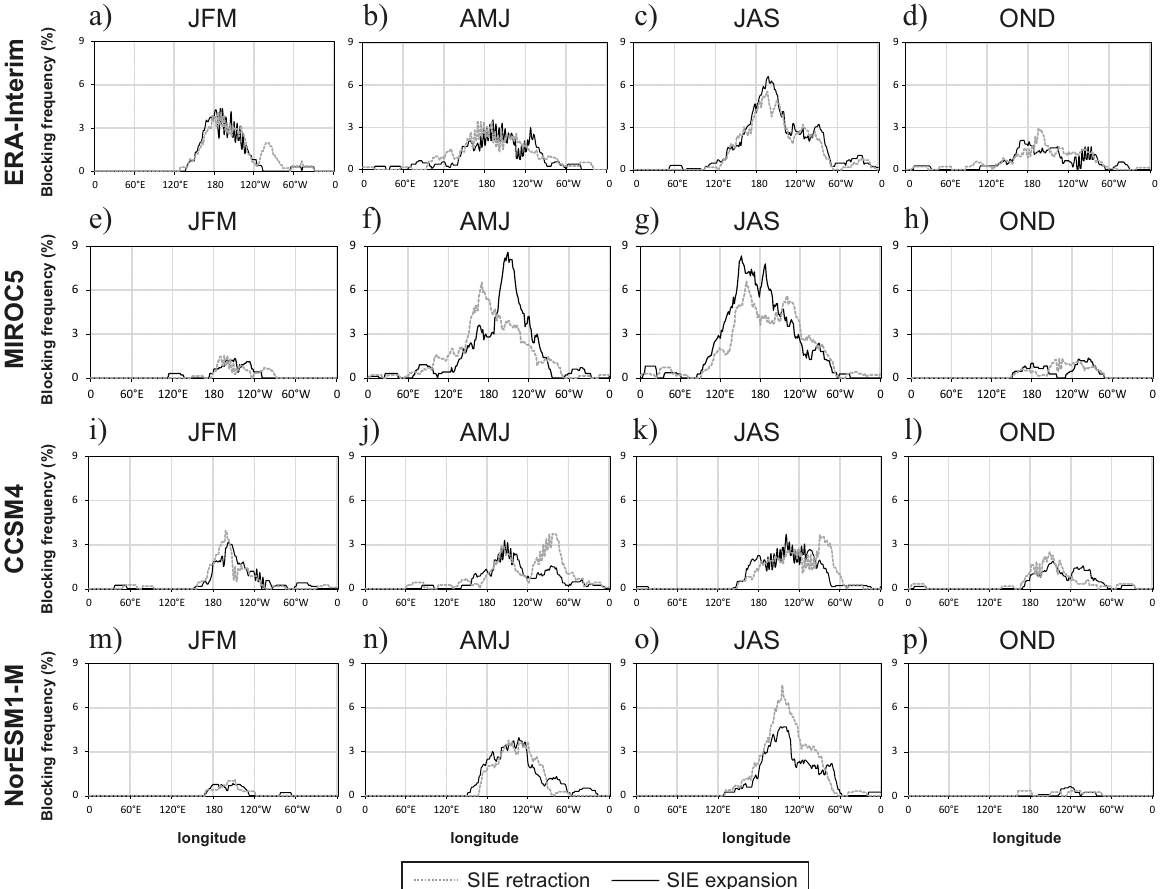
Figure 8. Seasonal frequency of blocking events, in the 48°S latitude band, in years of SIE Antarctic retraction (gray line) and expansion (black line) for (a, b, c, d) observed data (satellite and reanalyses), (e, f, g, h) MIROC5, (i, j, k, l) CCSM4 and (m, n, o, p) NorESM1-M during summer (JFM; first column), autumn (AMJ; second column), winter (JAS; third column) and spring (OND; fourth column) over